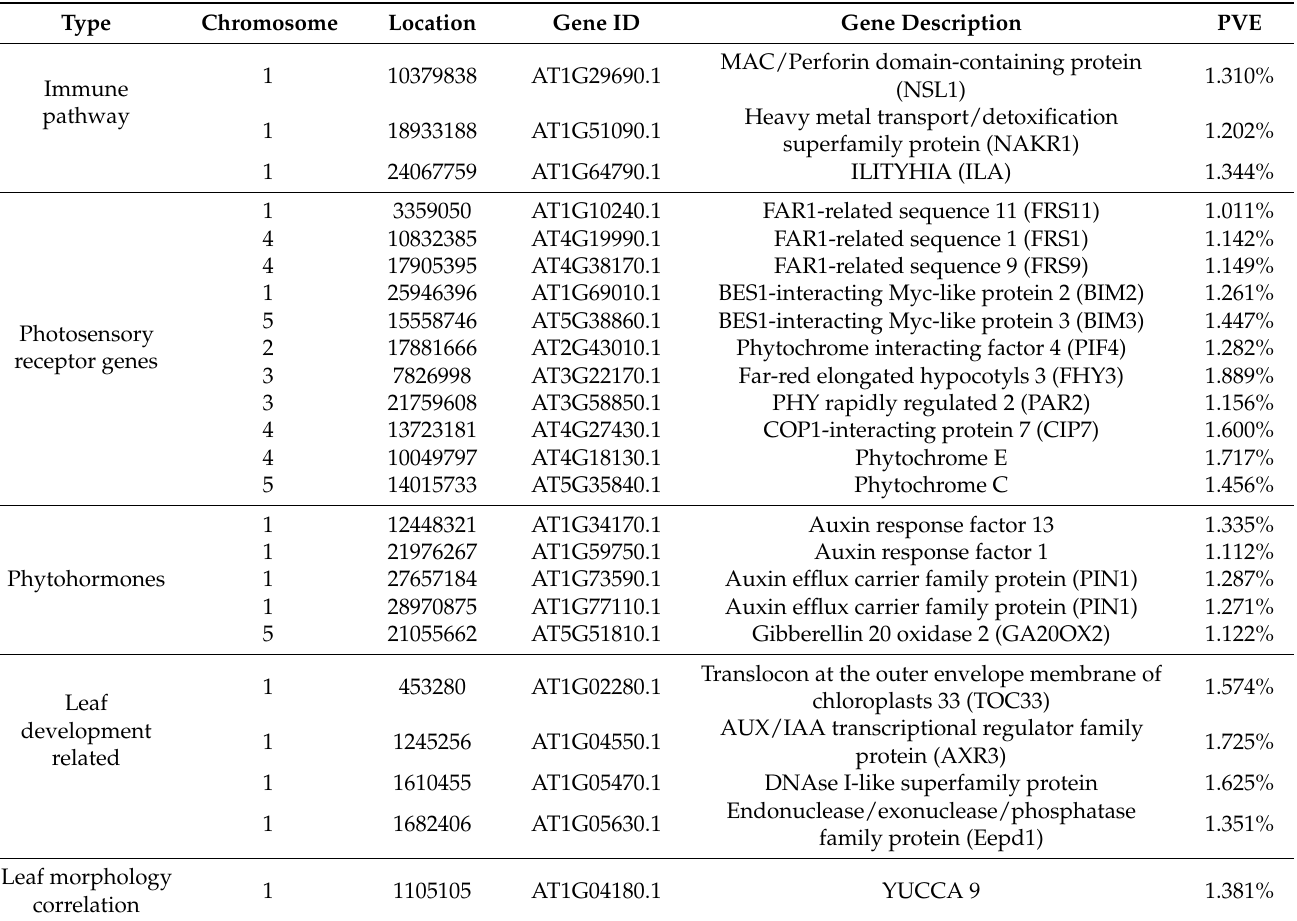
Table 2. Functional annotation of QTLs associated with allometry between the petiole length and leaf